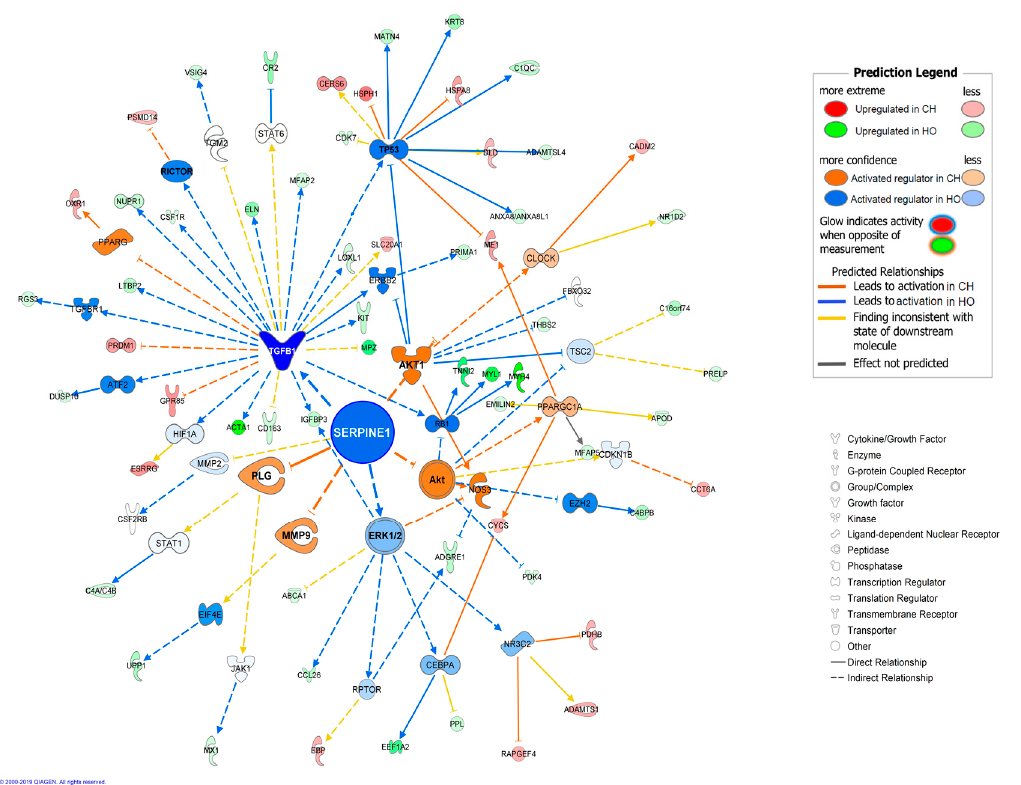
Figure 3. Predicted causal network for the DEG and master regulator SERPINE1 .